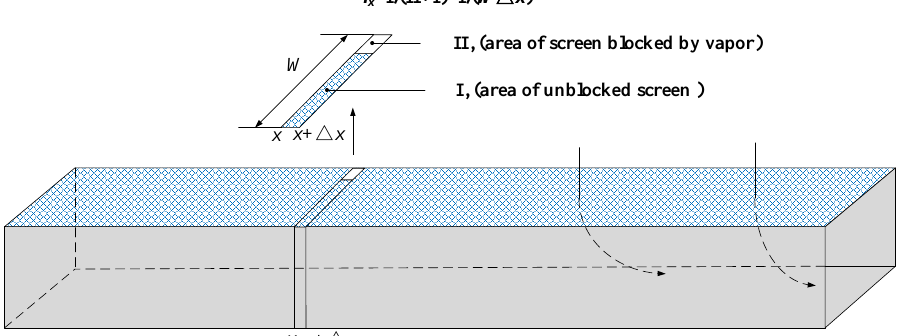
Figure 6. Definition of available rate f x.